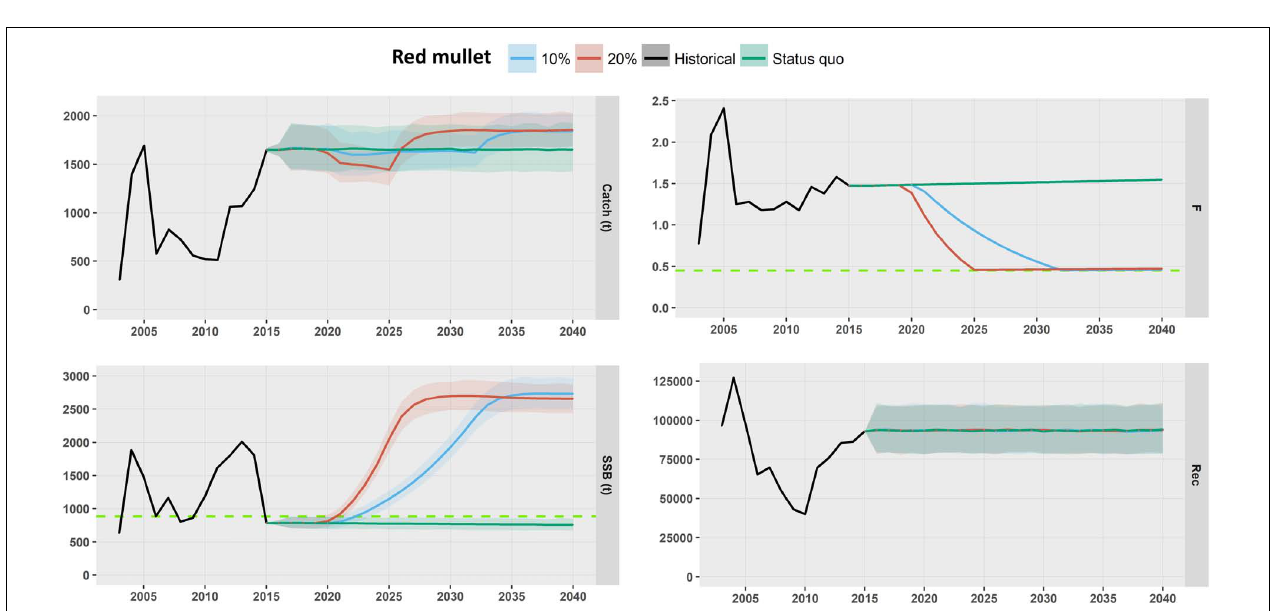
FIGURE 5 | Results of the bioeconomic model of catch (t), effort (average days at sea), profits (M€), and crew wages (€/day) for demersal longline fleet (HOK) under Scenario 0: status quo ; Scenario 1: 10% annual reduction; and Scenario 2: 20% annual reduction.